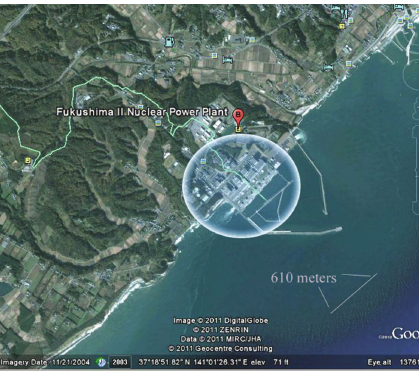
Figure 17: Project to cover the damaged Fukushima’s nuclear sta- tion by inflatable